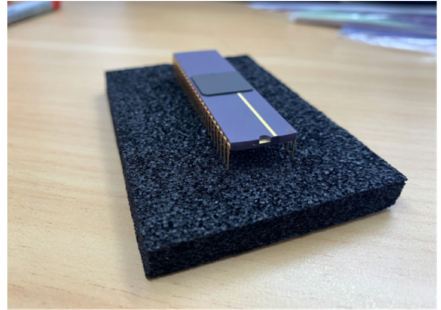
Figure 9. SCALDO integrated circuit (IC) prototype.